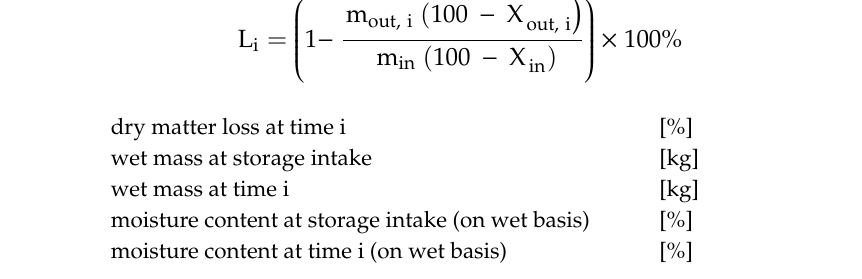
Figure 4. Division of the trees into three sections of equal weight.